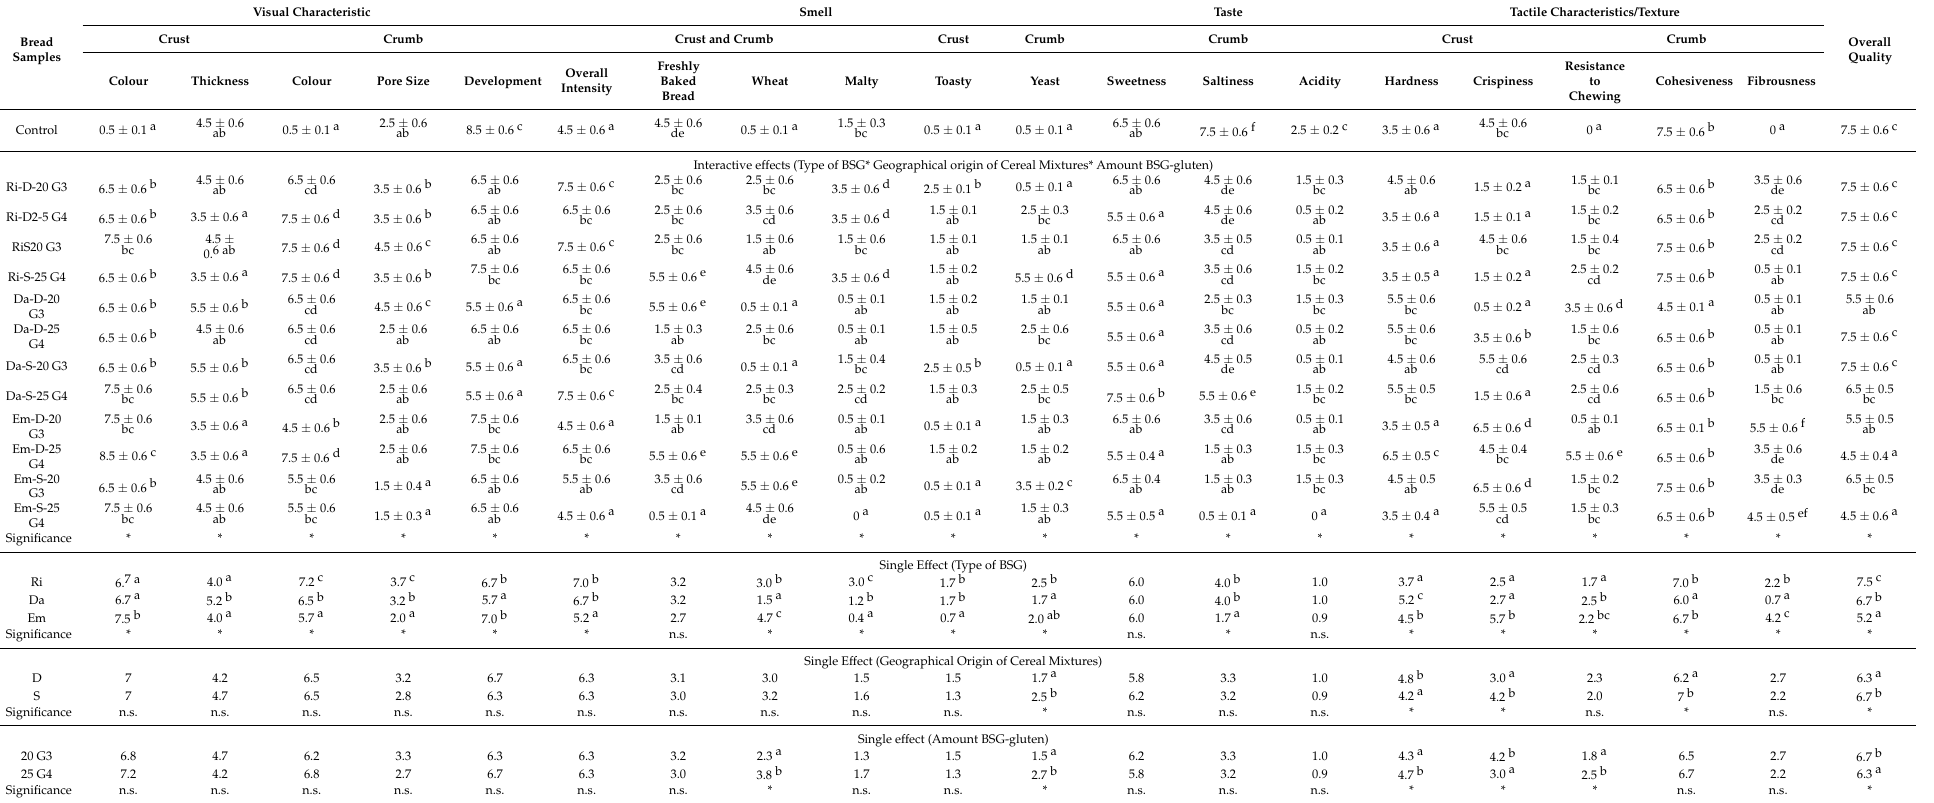
In column, different letters indicate significant differences at p < 0.01; * p < 0.01; n.s.: not